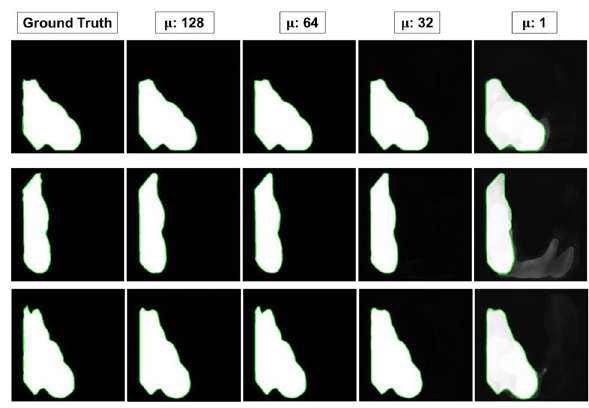
Figure 6. Boundary pixel lines drawn for a sample set of 3 input images. Each column represents the same PSNet model with different values of μ. Each row represents each of the 3 sample input